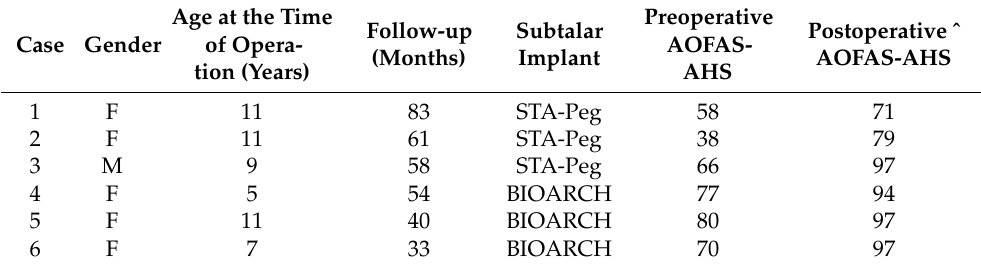
Table 1. The demographics for the included six patients.